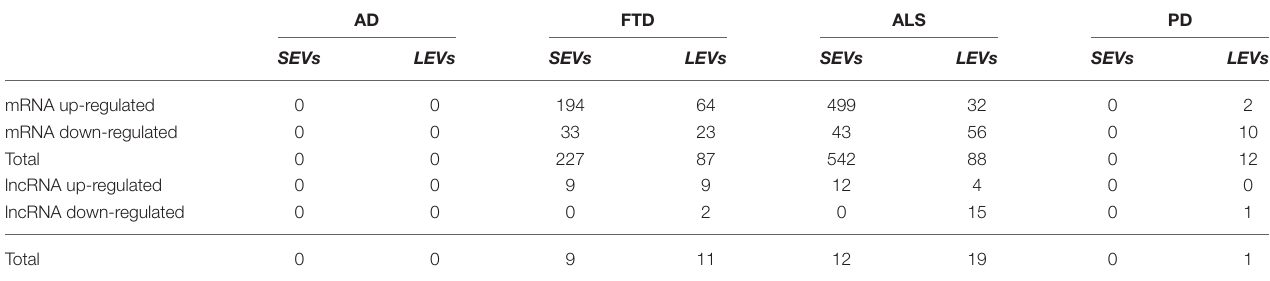
TABLE 2 | Statistically significant differentially expressed RNAs number in small extracellular vesicles (SEVs) and large extracellular vesicles (LEVs) from patients with Alzheimer’s disease (AD), frontotemporal dementia (FTD), amyotrophic lateral sclerosis (ALS), and Parkinson’s disease (PD) in terms of upregulated transcripts, downregulated transcripts, and total compared with CTRs. Transcripts were considered as differentially expressed when |log2(disease sample/healthy control)| ≥ 1 and an FDR ≤ 0.1. AD FTD